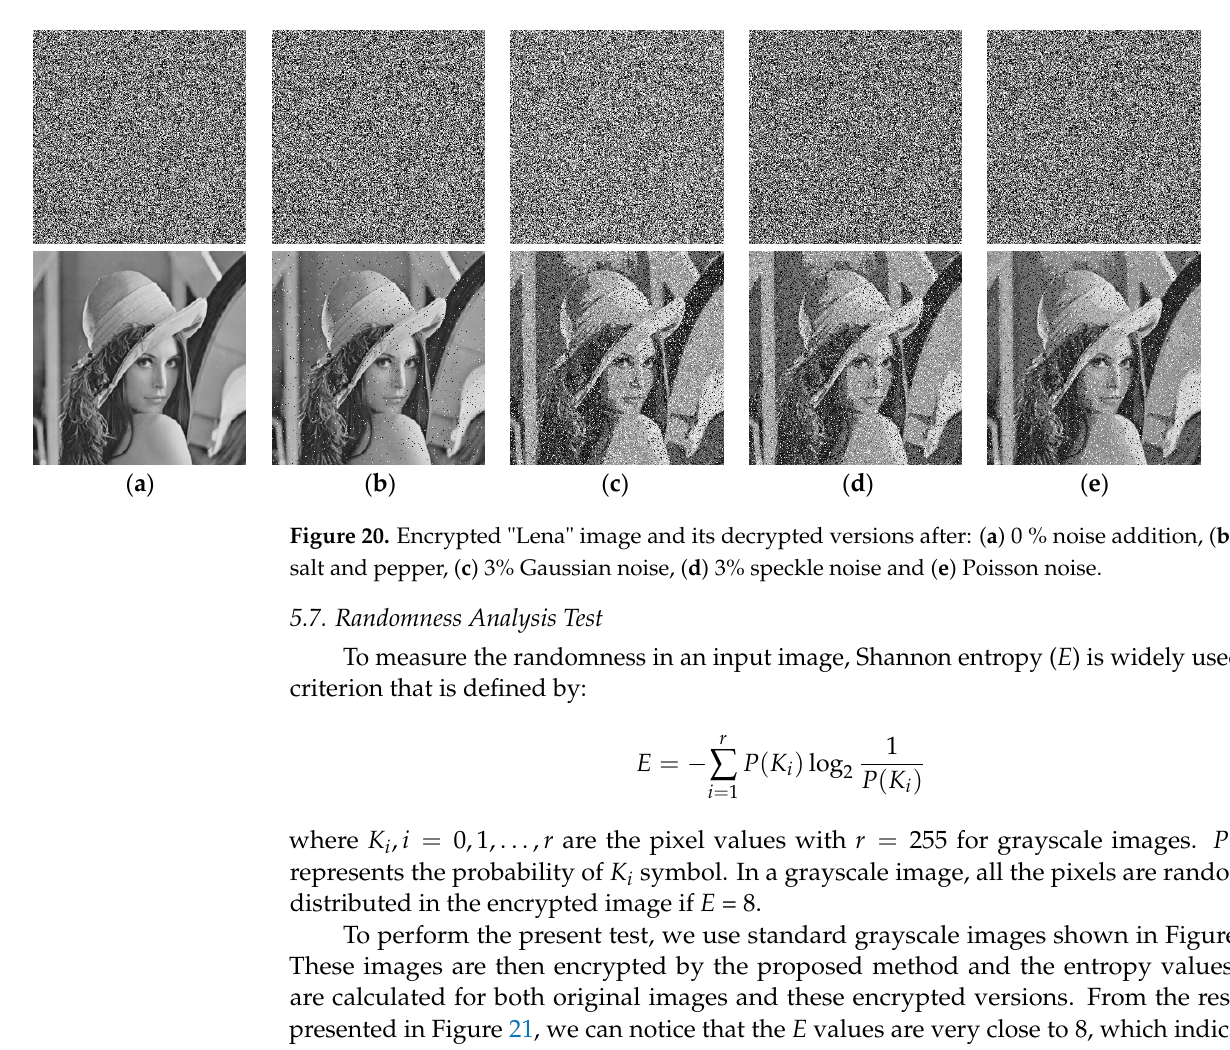
Figure 19. Encrypted “Lena” image in decrypted version after losing ( a ) 0, ( b ) 12.50%, ( c ) 25%, ( d ) 37.50% and ( e ) 50% of the encrypted image data.